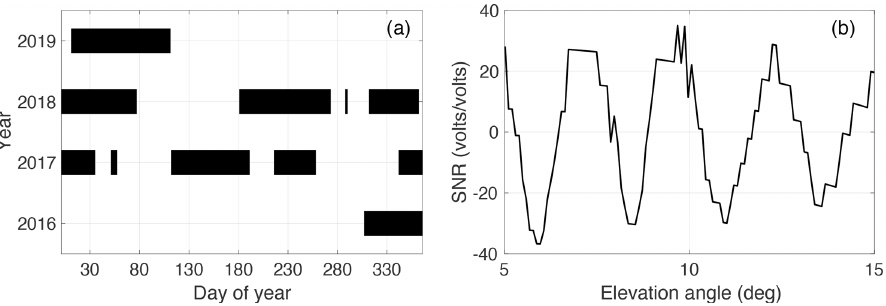
Figure 5. (a) Availability of the SNR data of the GPS L1 C/A signals recorded by QLBG during 2016–2019. (b) SNR observations with elevation angles of 5–15 ◦ of the GPS-02 satellite on DOY 220 in 2018. The second-order polynomial has been